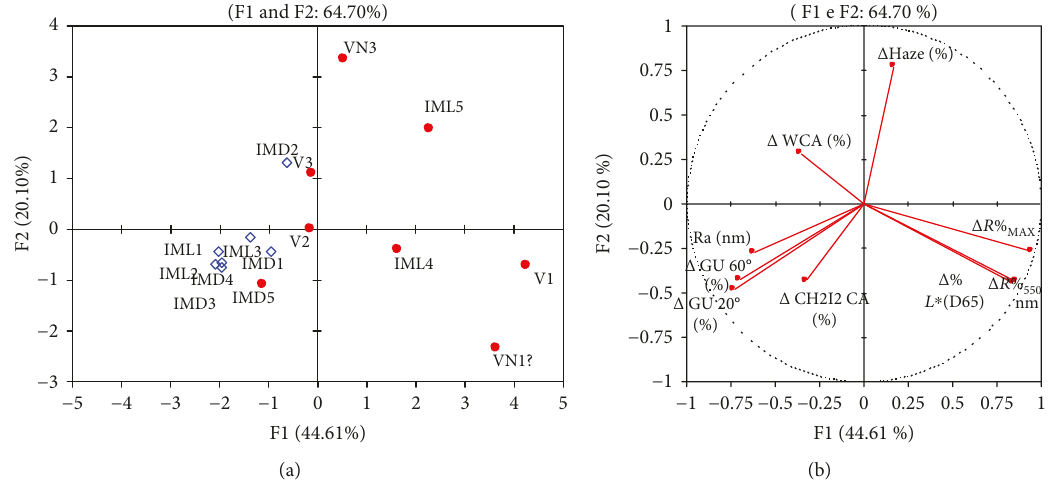
Figure 6: Score and loading plots from PCA performed with all variables. Score plot: (a) closed red marks represent “ visible ” and empty marks represent “ nonvisible. ” Loading plot (b).